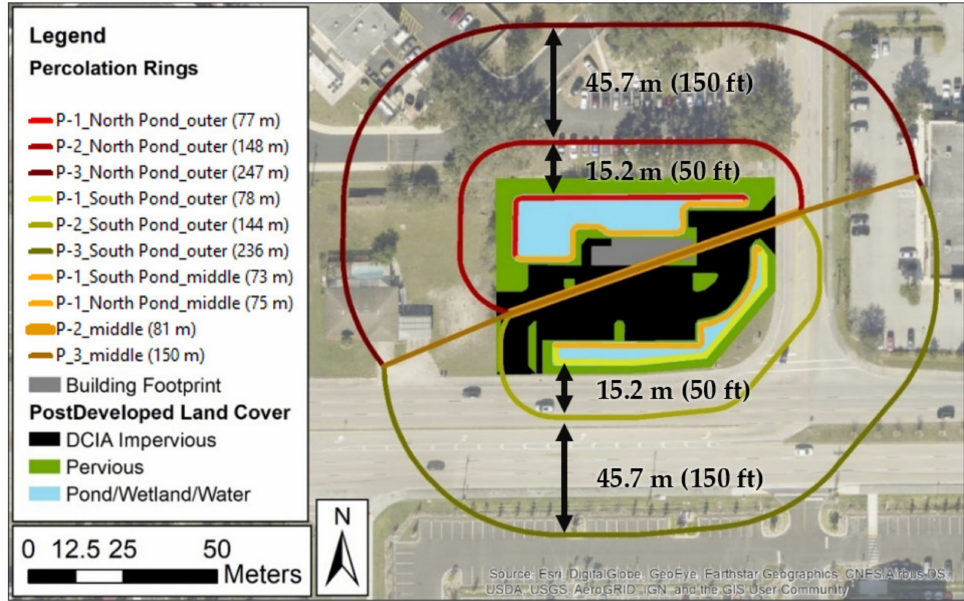
Figure 10. Post-development percolation ring delineation.